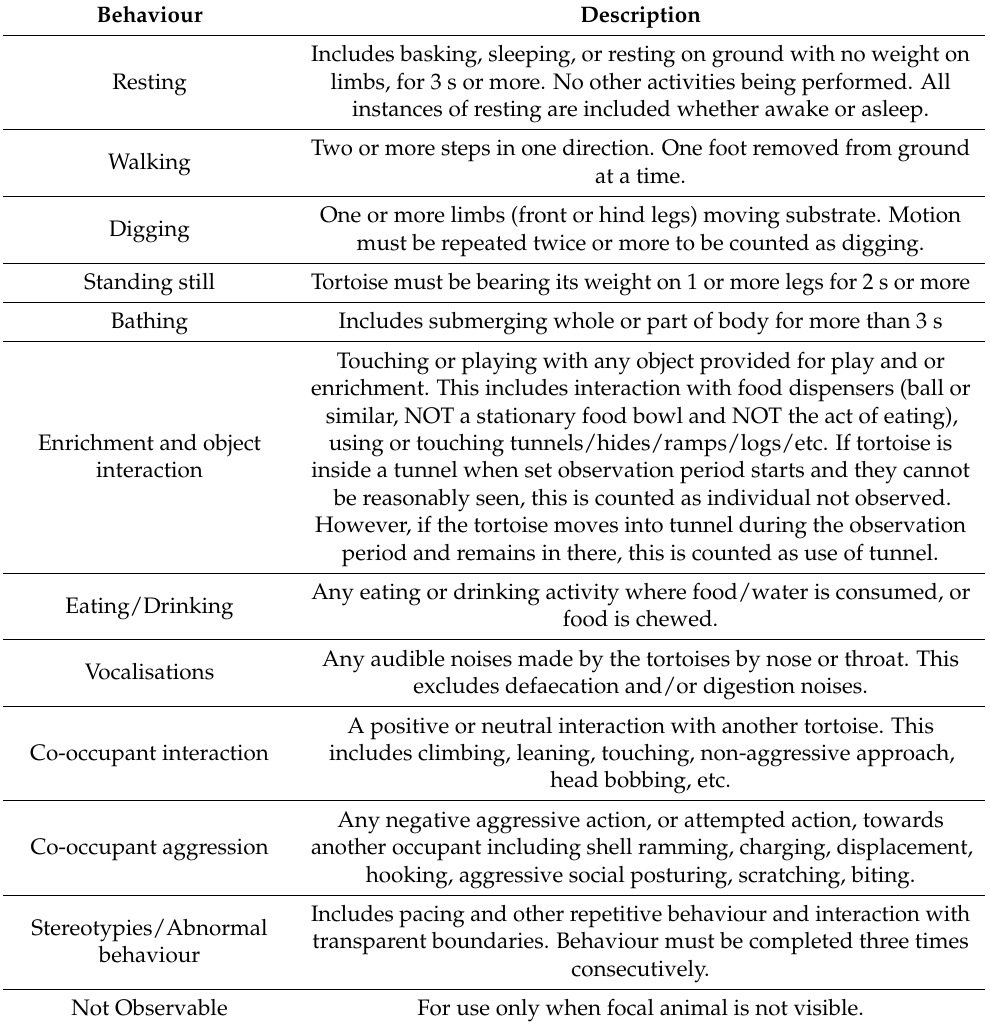
Table 1. Ethogram used for behavioural analysis modified from